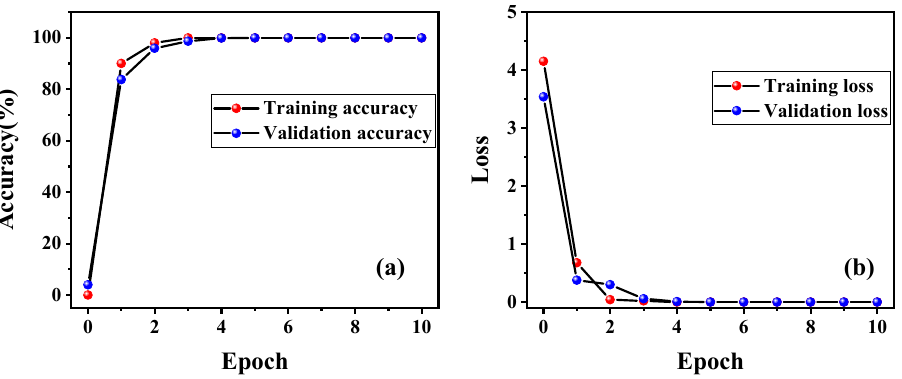
Figure 3. Speckle patterns corresponding to different refractive indexes and their differences between the adjacent speckle patterns.